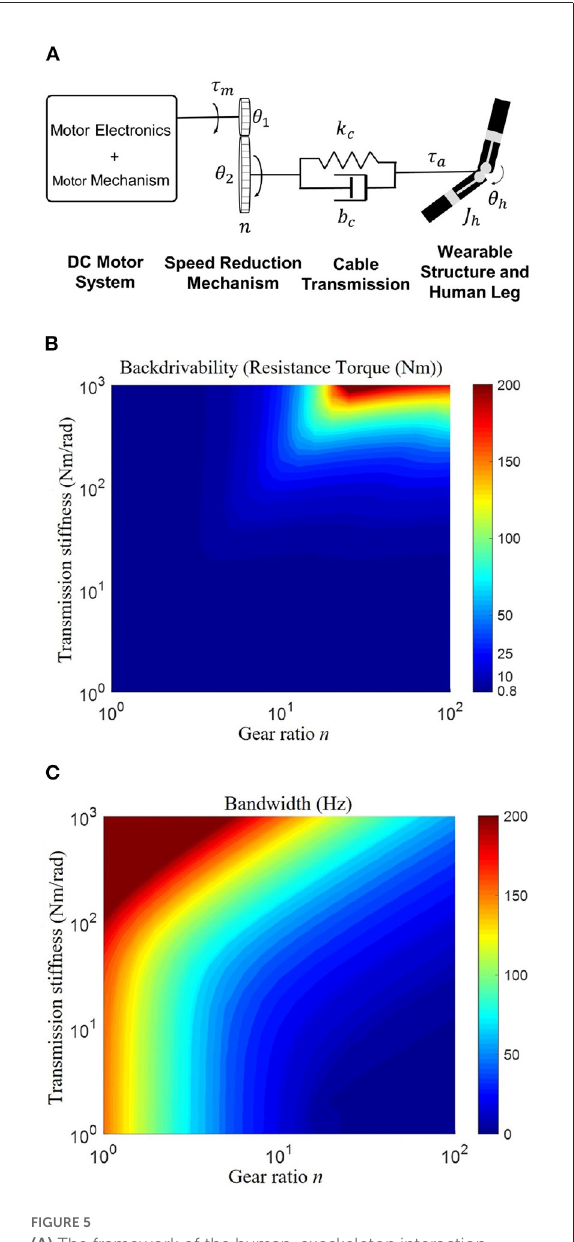
FIGURE5 (A) The framework of the human-exoskeleton interaction model. This model consists of four modules: motor system, speed reduction mechanism, cable transmission, and wearable structures attached to the human. θ 1 and θ 2 denote the rotation angles of the input gear and output gear, respectively. n , speed reduction ratio; k c , transmission stiffness; b c , transmission damping; J h , joint inertia of the shank orthosis and human shank; θ h , knee angle; τ m , motor torque; τ a , exoskeleton actual torque. (B,C) Influence of gear ratio and transmission stiffness on backdrivability and control bandwidth. (B) Illustrates the high backdrivability is ensured by either high transmission stiffness or small gear ratio; (C) Shows the high bandwidth requires both high transmission stiffness and small gear ratio. Therefore, both a high transmission stiffness and a small gear ratio are necessary to ensure high backdrivability and high